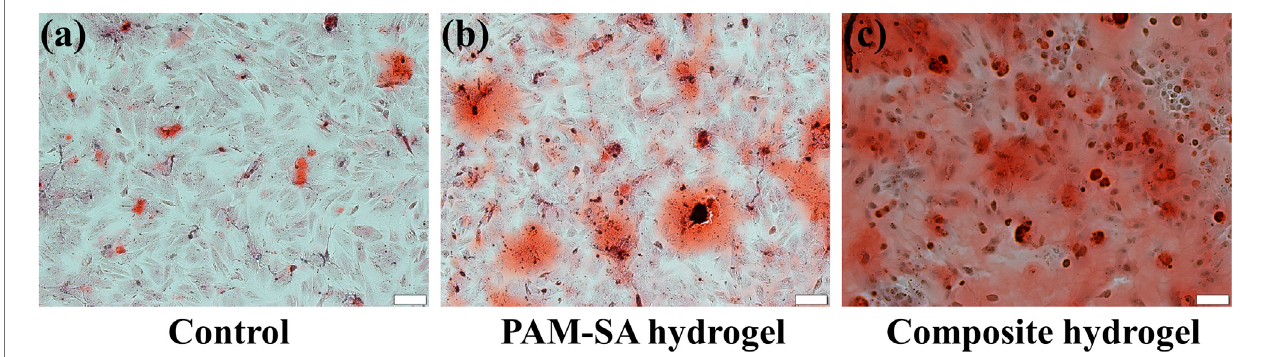
FIGURE 5 | Alizarin Red S-stained photos of rBMSCs on the 21st day. (A) Control group; (B) PAM-SA hydrogel group; (C) Composite hydrogel group. The scale bar is 100 µm.